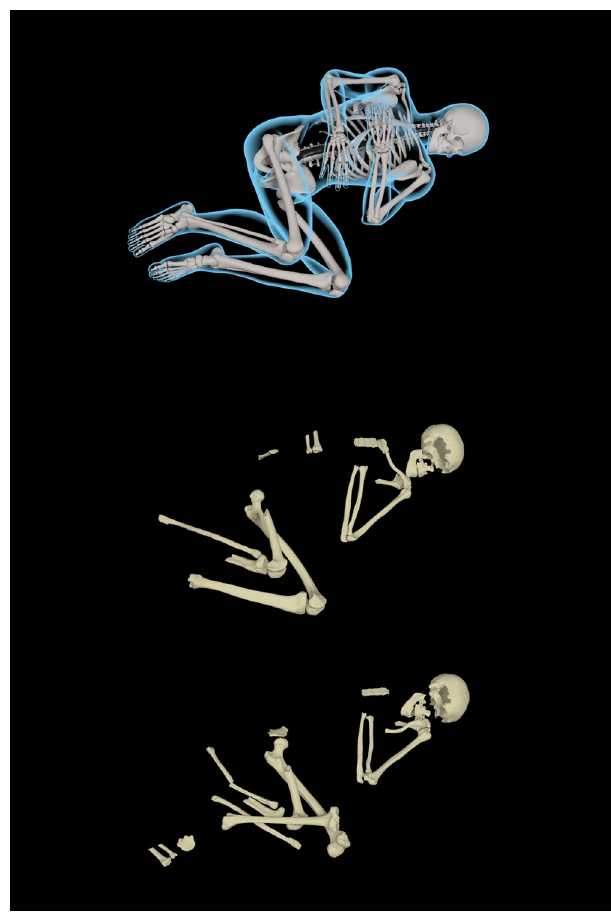
Figure 7: Top: posed Motioncow anatomical reference body. Middle: reconstructed position A of the skeleton. Bottom: reconstructed position B of the